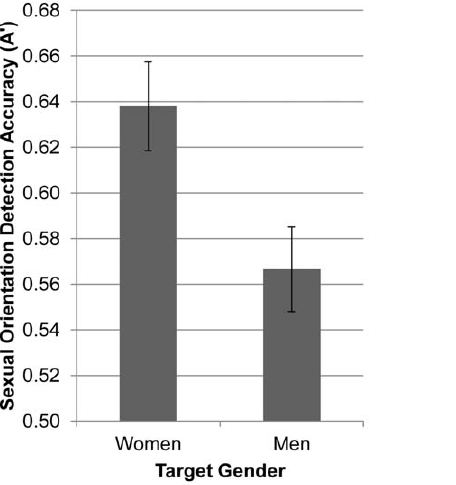
Figure 2. Accuracy of detecting sexual orientation from upright faces (Experiment 1). Mean accuracy (A 9 ) in judging sexual orientation from faces presented for 50 milliseconds as a function of the target’s gender (Experiment 1). Error bars represent 6 1 SEM .